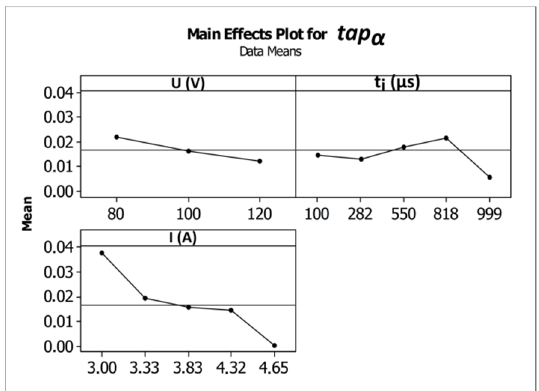
Figure 8. Influence of the machining parameters ( U , t i , I ) on the values of the taper angle ( tap α ).